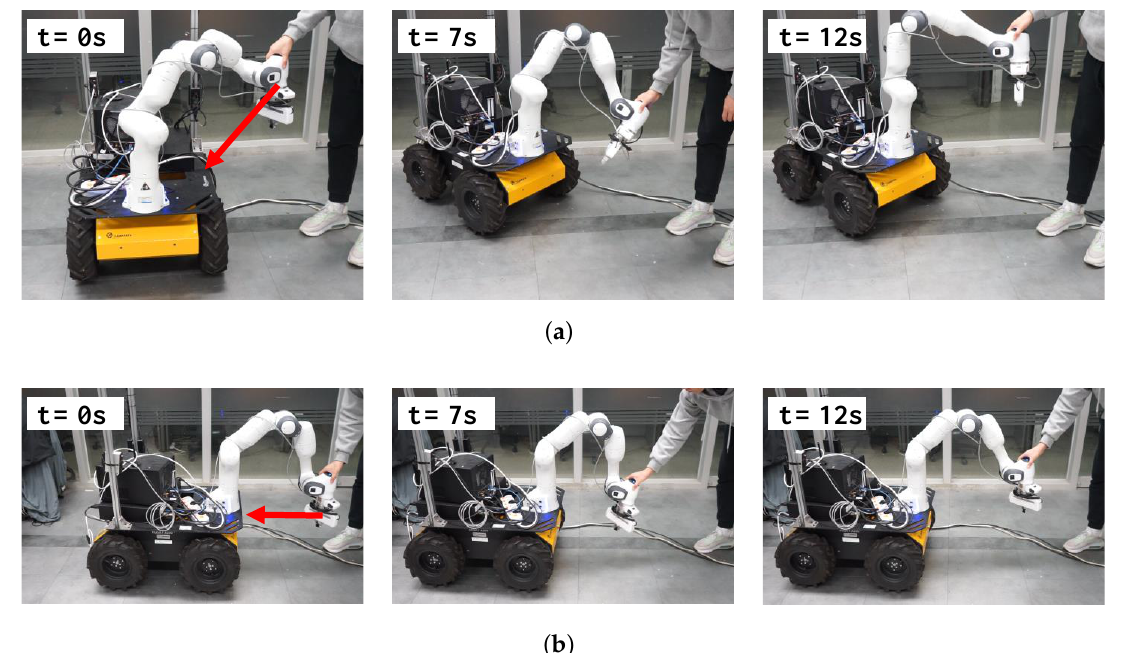
Figure 13. ( a ) The snapshots during the experiment that the manipulator approaches the mobile from the lateral direction; ( b ) the snapshots during the experiment that the manipulator approaches the mobile robot from the front direction. Red arrows show the guiding directions.